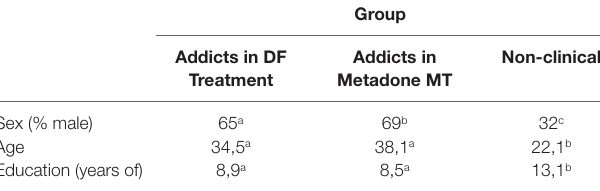
TABLE 1 | Demographic characteristics of